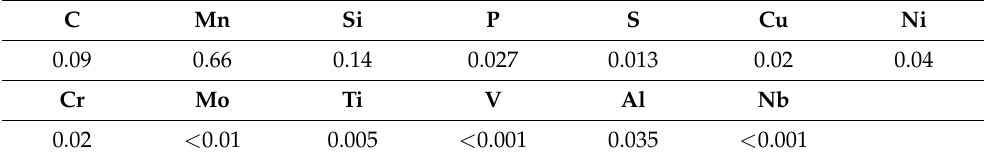
Table 1. Chemical composition of the steel. All values in wt.